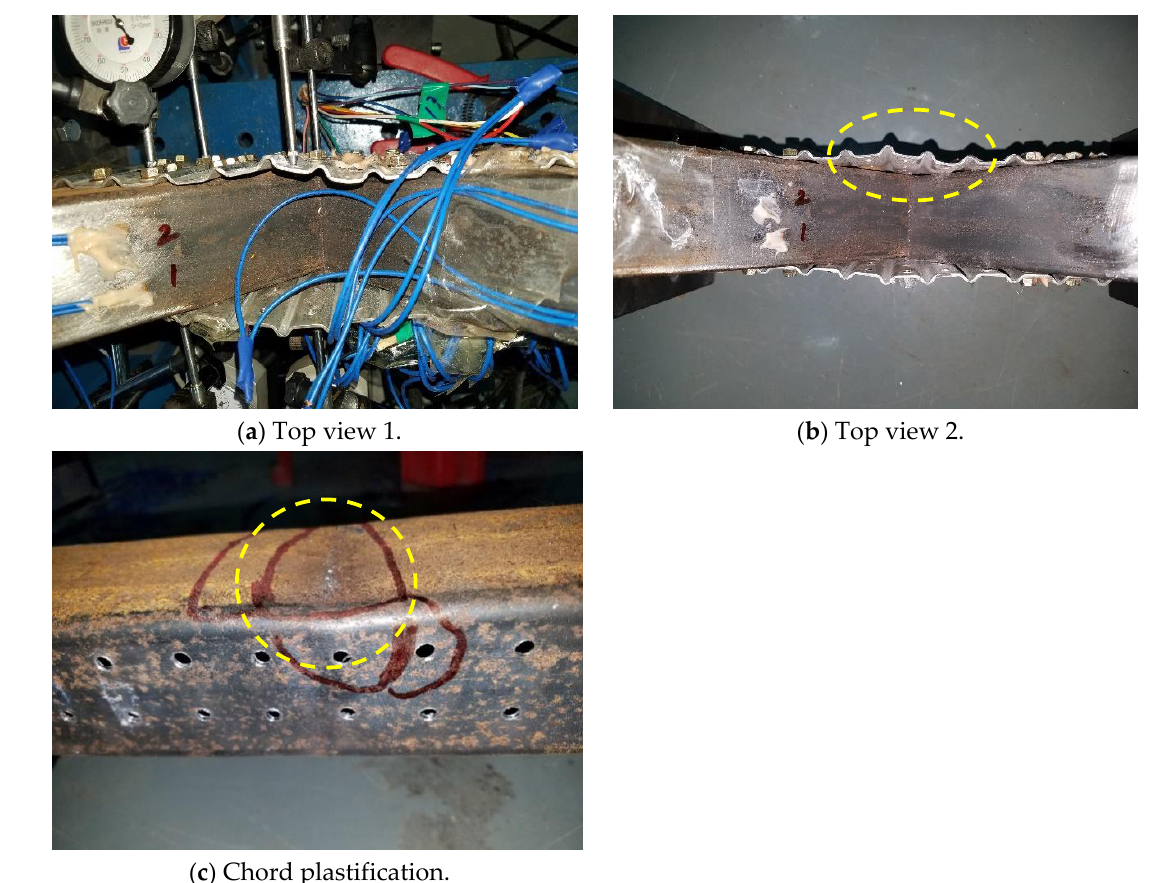
Figure 14. Deformation of specimen ULW-1.